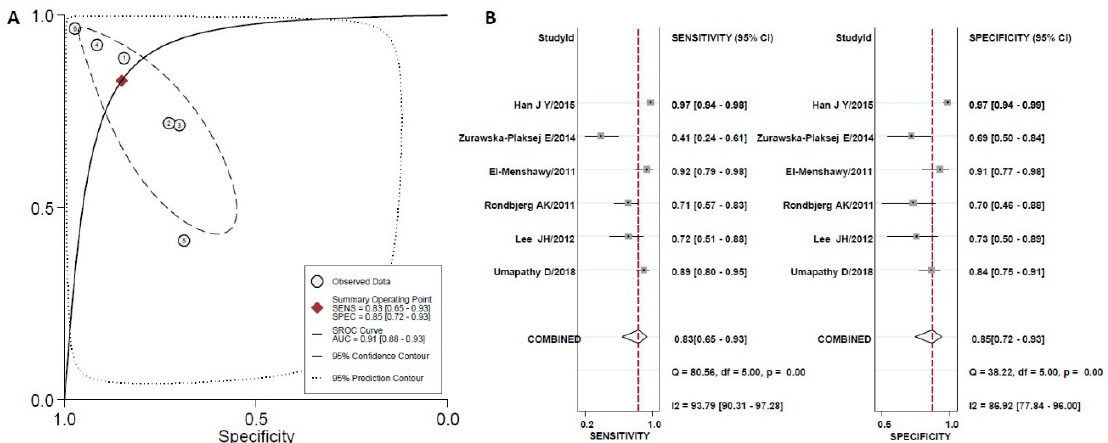
Figure 3. ( A ) The hierarchical Summary Receiver Operating Characteristic curve of YKL-40 to discriminate controls (healthy individuals) from normoalbuminuric T2DM patients. The straight line represents the hSROC curve; the circle represents each of the analyzed studies; the diamond shape represents the point estimate to which overall sensitivity and specificity correspond. ( B ) Forest plot for sensitivity and specificity.